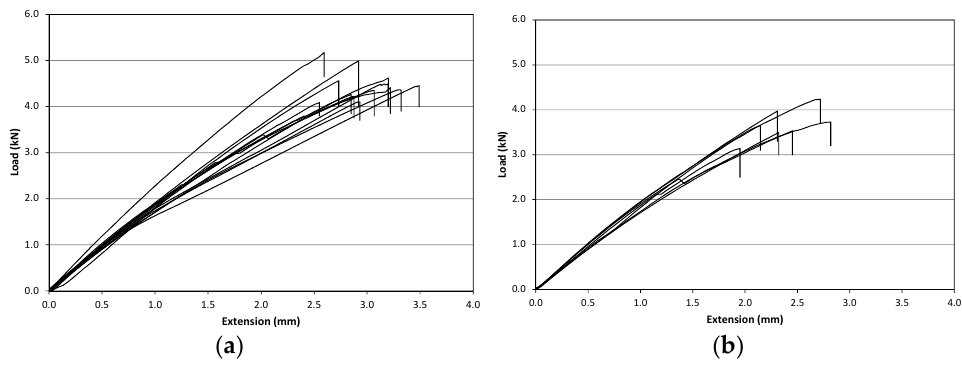
Figure 8. Load-extension curves for untreated specimens: ( a ) SR-series; ( b ) SC-series.